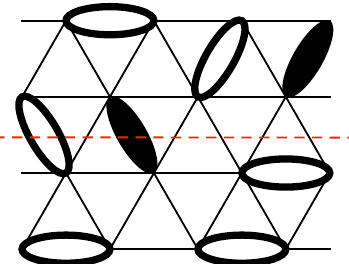
Figure 1: Example of a hard-core dimer configuration spanning the Hilbert space of our triangular lattice model. White ellipses represent bosonic spin-singlet dimers, black ellipses are fermionic dimers. The parity of the number of bosonic and fermionic dimers crossing the red dashed line does not change under arbitrary lo- cal dimer rearrangements, as expected for a state with Z 2 topological